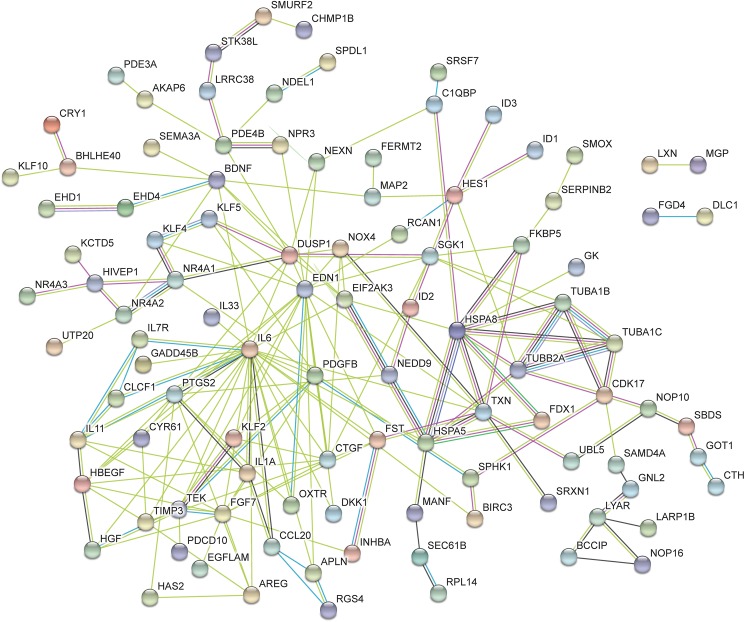
This network represents the differentially expressed genes regulated in thrombin transactivation of both the EGFR and TGFBR1.The functions of this network include biological processes, molecular functions and cellular component. The color of the nodes indicates the query protein and its first shell of interactions. Protein nodes which are enlarged indicates the availability of 3D protein structure information. The colored lines between the nodes indicated the query protein-protein interactions. The known interactions is a light blue (from curated database) or pink (experimentally determined) lines between the proteins. The predicted interactions use green (gene neighborhood), red (gene fusion) and dark blue (gene co-occurrence) lines. The yellow represents text mining, the black represent co-expression and the purple lines represent protein homology.